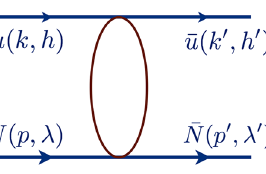
Fig. 1 Elastic lepton–proton scattering